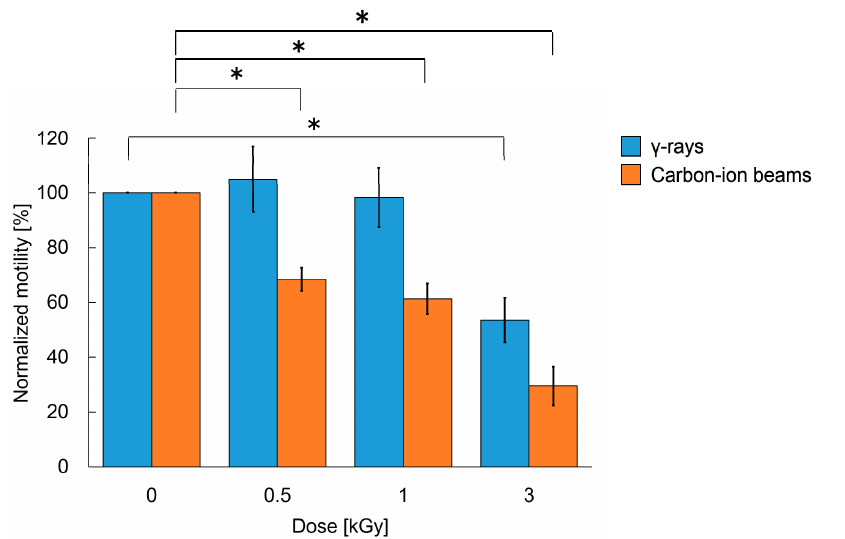
Figure 3. Crawling ability of C. elegans immediately after whole-body irradiation with different doses of γ -rays and carbon ion beams. Normalized value of motility of worms immediately (at 0 h) after whole-body irradiation compared with the non-irradiated worms. Track length (trajectory) of the center point of the body in crawling on agar for 5-s was derived from a video, as shown in Figure 2B, and the value was divided by the worm length. In both cases of γ -rays and carbon-ion beam irradiation, the values of 5 worms were averaged at each dose, and the means of worms irradiated with each dose (0, 0.5, 1, and 3 kGy) immediately after irradiation (at 0 h) were divided by each mean value of the corresponding non-irradiated control worms (0 Gy at 0 h). By using this normalized value representing the ratio of motility in crawling on agar, the effects of irradiation on motility can be exactly evaluated. Thirty worms were tested in each condition in 6 trials of γ -rays irradiation (5 worms per condition per trial). Twenty worms were tested in each condition in 4 trials of carbon-ion-beams irradiation (5 worms per condition per trial). The mean values of the normalized motility of 6 or 4 irradiation trials are presented in blue or orange, respectively. Error bar indicates SEM. The data were analyzed by the Student’s t -test. * indicates p -value < 0.05, significantly different from 0 Gy.